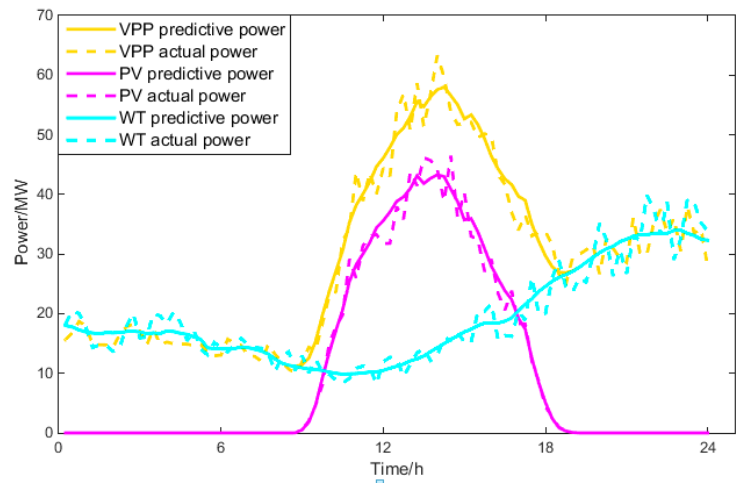
Figure 8. The output curves of typical scenario 12.